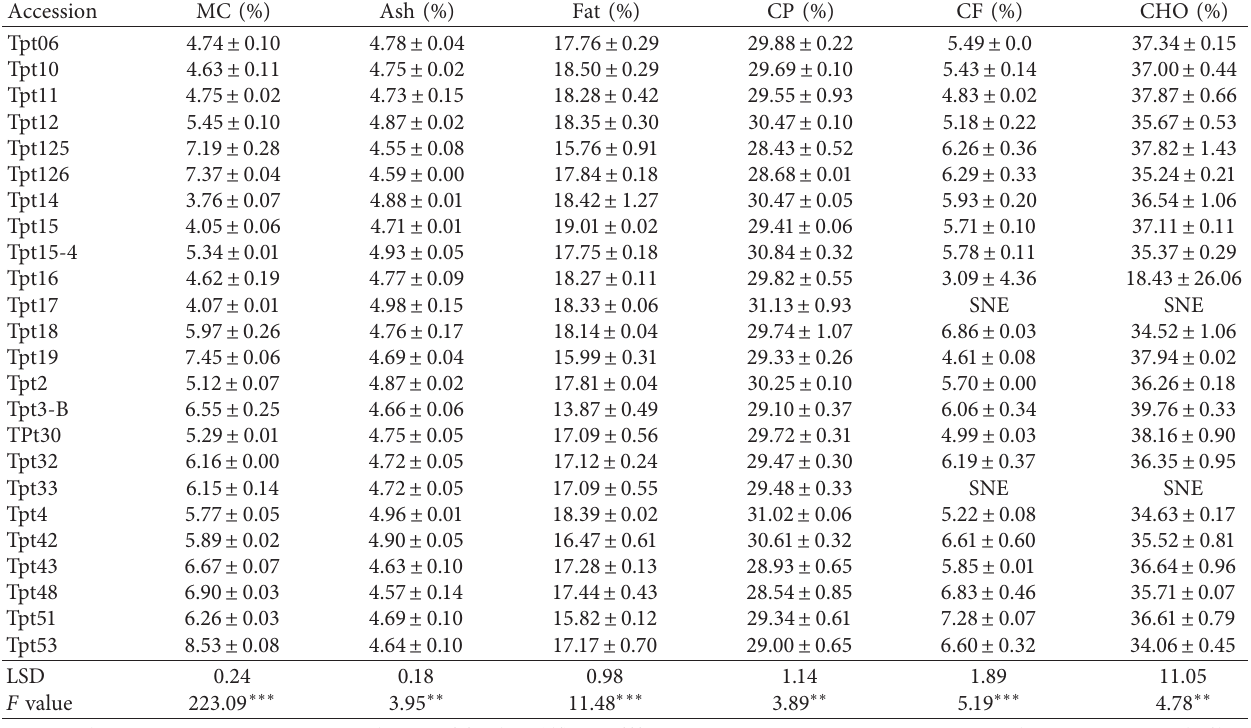
Table 4: Proximate composition (mean ± standard deviation) of unprocessed seeds of winged bean.